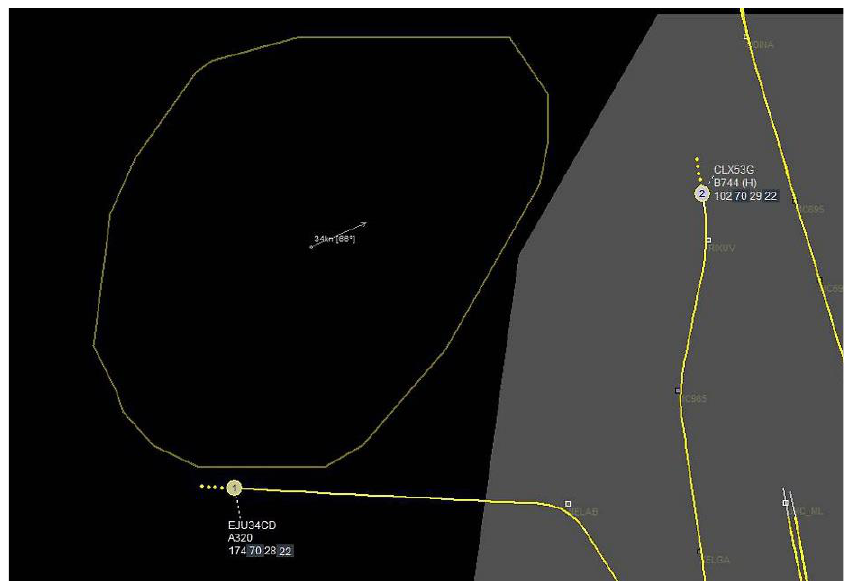
Figure 18. The dark color scheme with convective zones displayed as bordered areas. Malpensa traffic mix from 11 May 2019 with weather from 11 May 2019 and the WRF-RUC nowcast model.